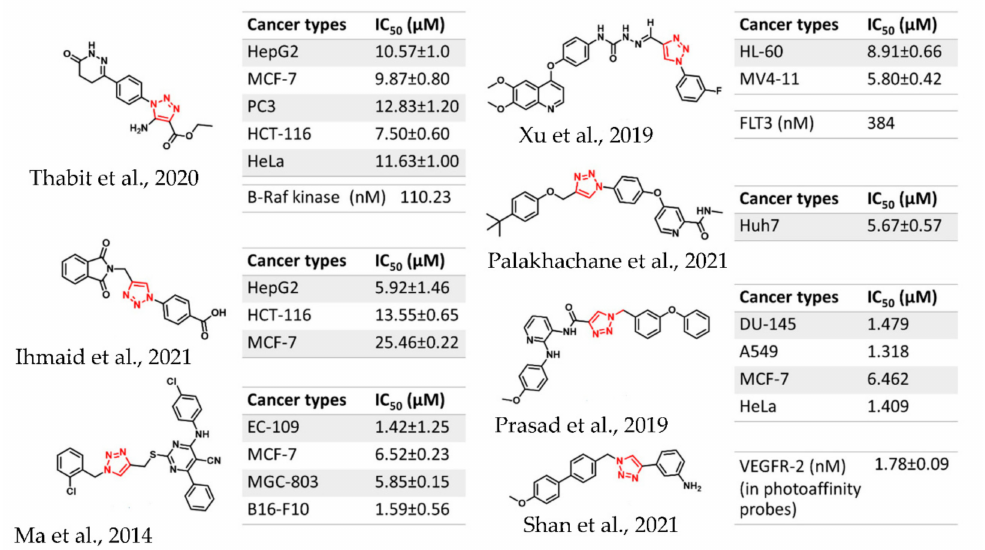
Figure 2. Some 1,2,3-triazole-containing analogs with their kinase-inhibitory and anti-cancer activi- ties